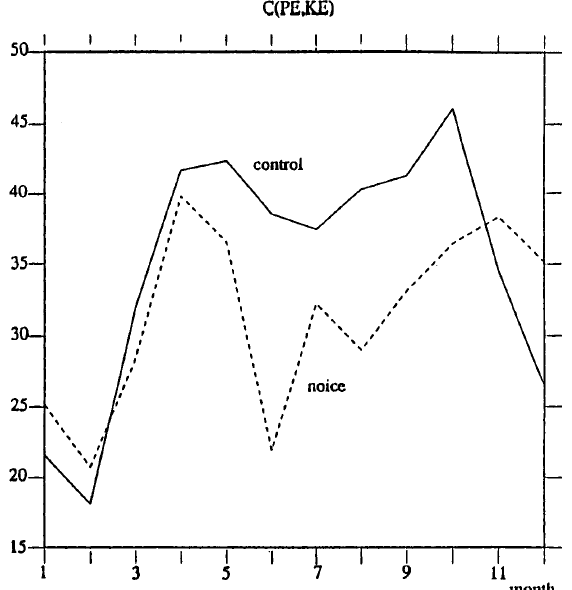
Fig. 12. Seasonal variation of the rate of conversion between eddy potential energy and eddy kinetic energy, averaged between 50 (cid:176) S and 65 (cid:176) S, in 0.1 Wm )